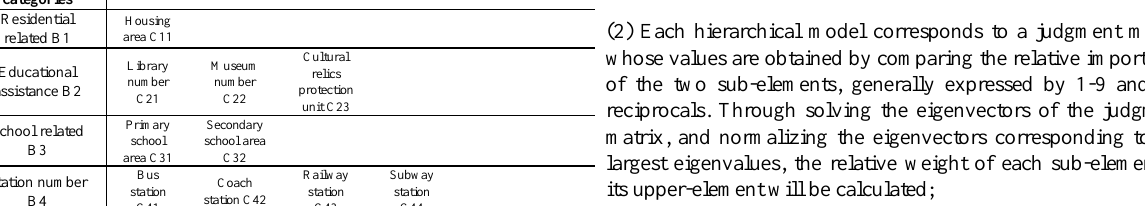
Table 1. Spatial data categories related to waterlogging impacts Major